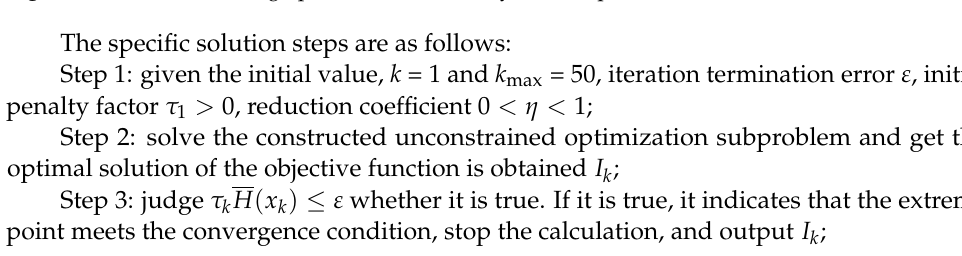
Figure 6. Process of solving optimization model by interior point